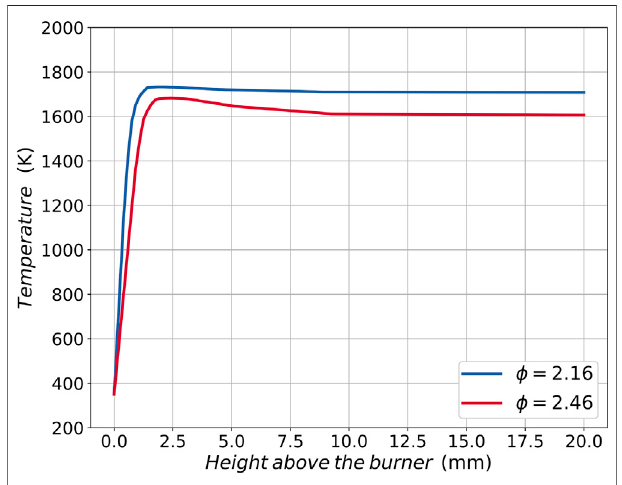
FIGURE 1 | Prescribed temperature pro fi les as a function of the height above the burner for the two different investigated equivalence ratios ϕ (cid:1) 2.16 and ϕ (cid:1) 2.46. Pro fi les adapted from Russo et al. (2019) for pure ethylene fl ames.